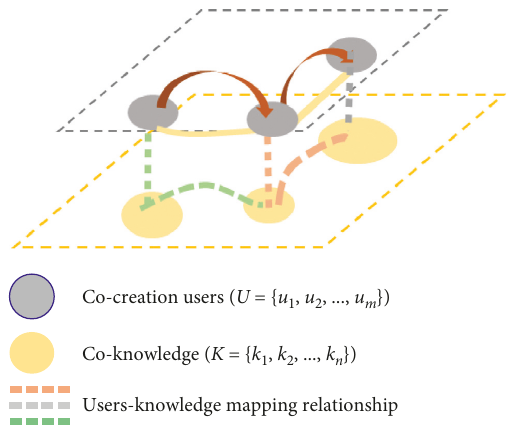
Figure 9: Co-creation user network-knowledge network mapping relationship. Figure 10: User network-product network mapping relationship.